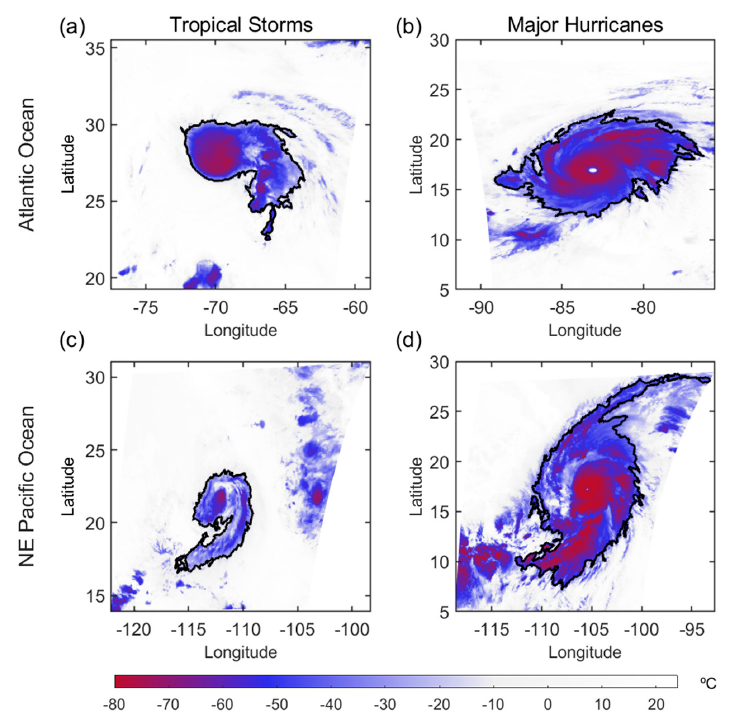
Figure 3. Overview of the main features common to most tropical storms. The images show the typical shape, dimension, and BT distribution for a TS and MH at their intensity peak over the Atlantic and the NE Pacific oceans. All figures shown are for illustration purposes only and correspond to: ( a ) TS Chantal (1995); ( b ) category 5 Hurricane Mitch (1998), ( c ) TS Elida (1996); and ( d ) category 5 Hurricane Patricia (2015). Units in degrees Celsius.